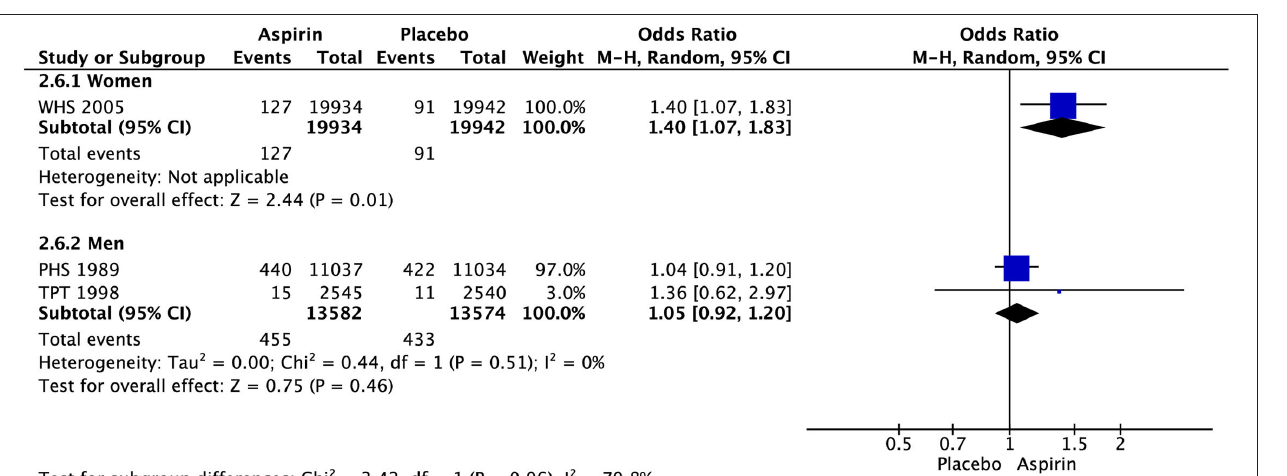
FIGURE 7 | Gastrointestinal bleeding in women and men taking aspirin or